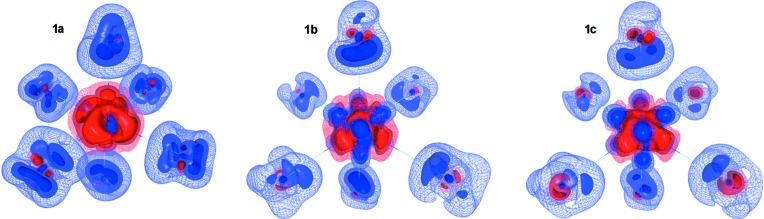
Deformation density isosurface map for the UF6
− anion obtained from models 1a–1c. Charge concentrations are depicted in blue and depletions in red. The isodensity surfaces are plotted from the ±0.15 (mesh), 0.30 and 0.45 (most opaque) eÅ−3 levels.